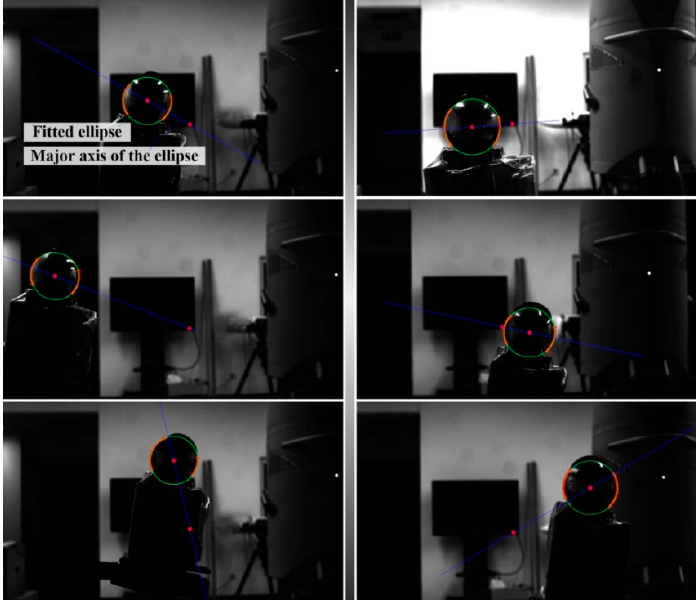
Figure 4. Six examples of ellipse detection and fitting results for the right projection images.